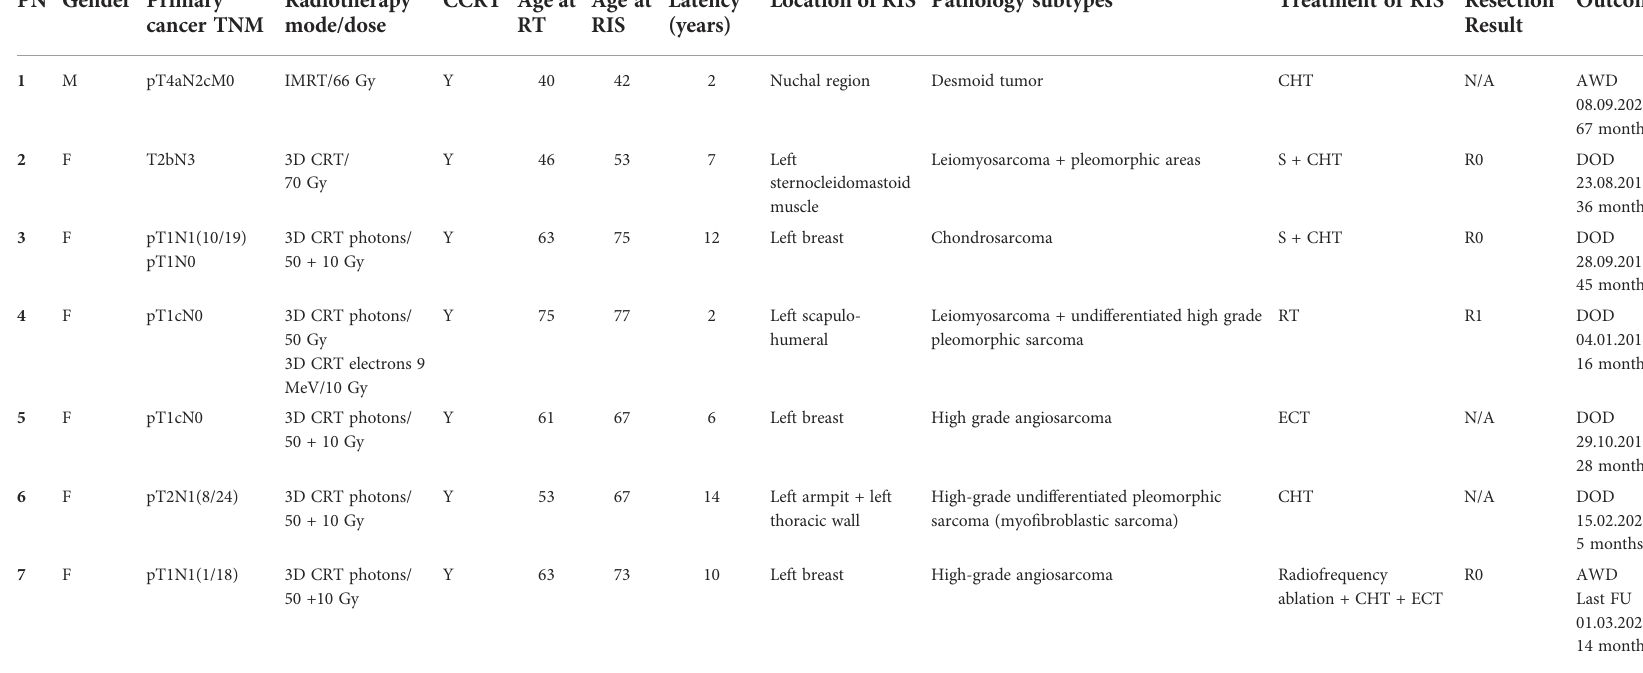
TABLE 2 Histological features, therapeutic management, and follow-up information of radiation-induced